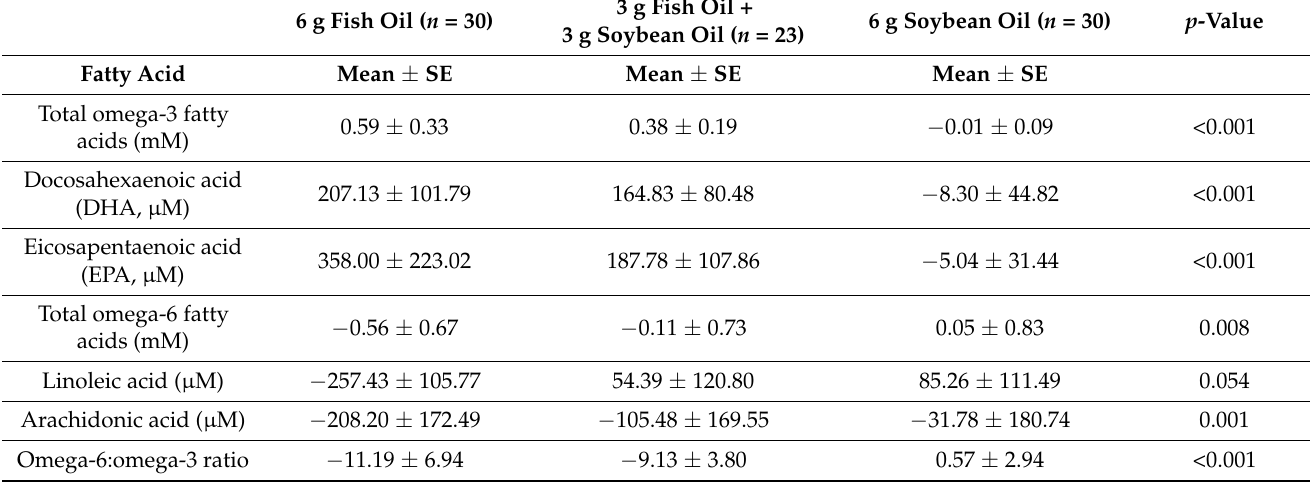
paring changes in fatty acids between